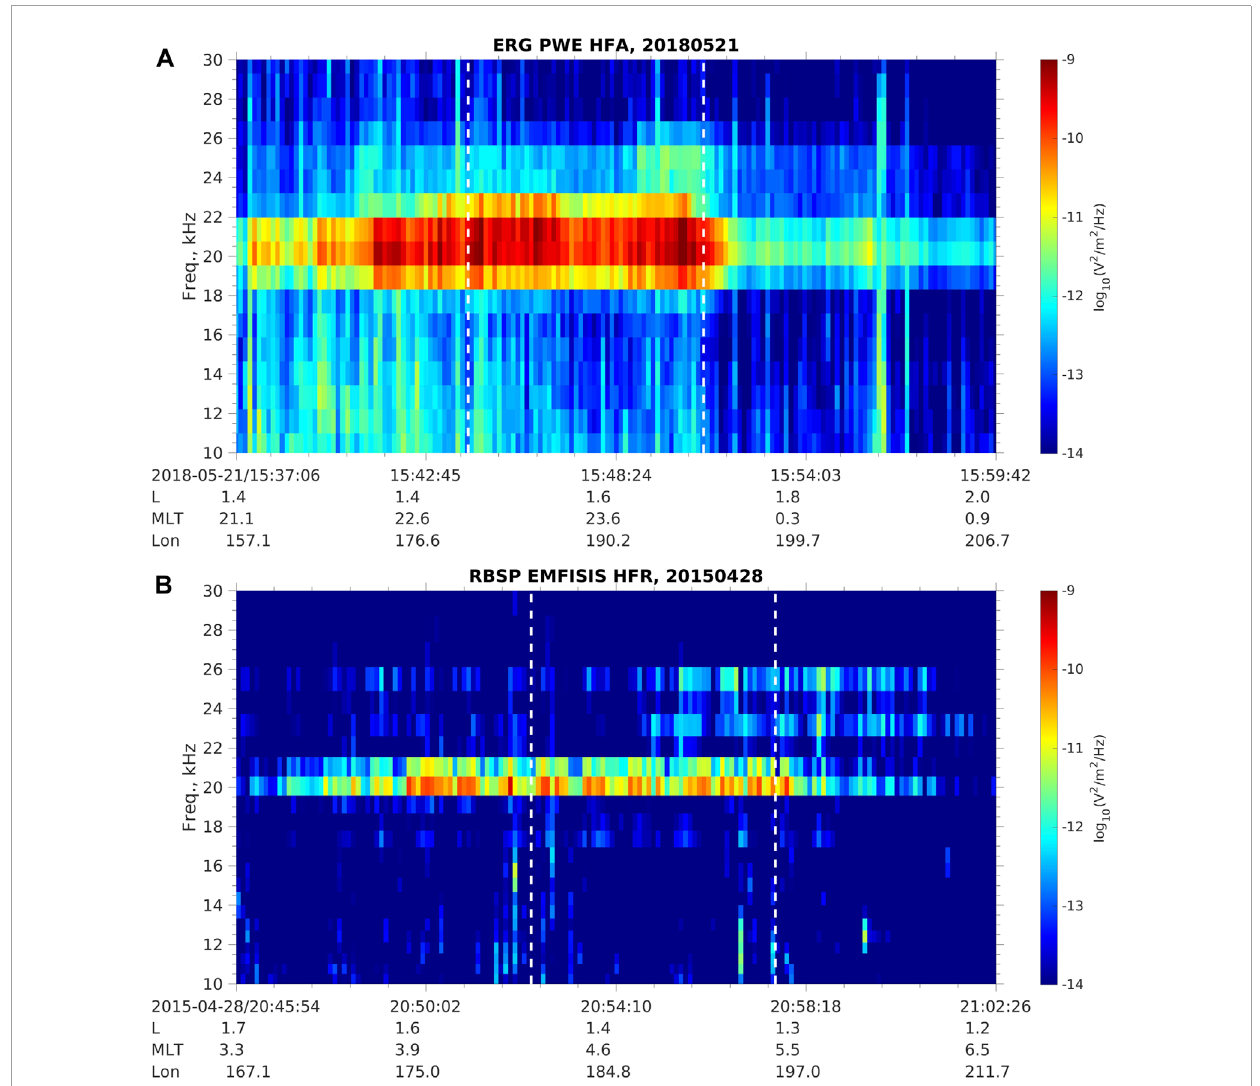
FIGURE 1 Example of NWC transmitter wave spectra observed by ERG/Arase PWE HFA (A) and Van Allen Probes EMFISIS HFR (B) . The white vertical dashed lines indicate the longitude boundaries of the NWC signal filter.